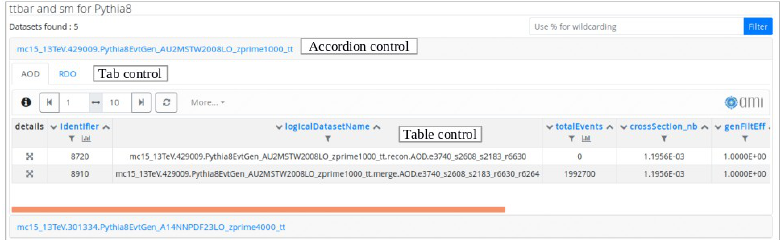
Fig. 10. The “PMG view” composite control for